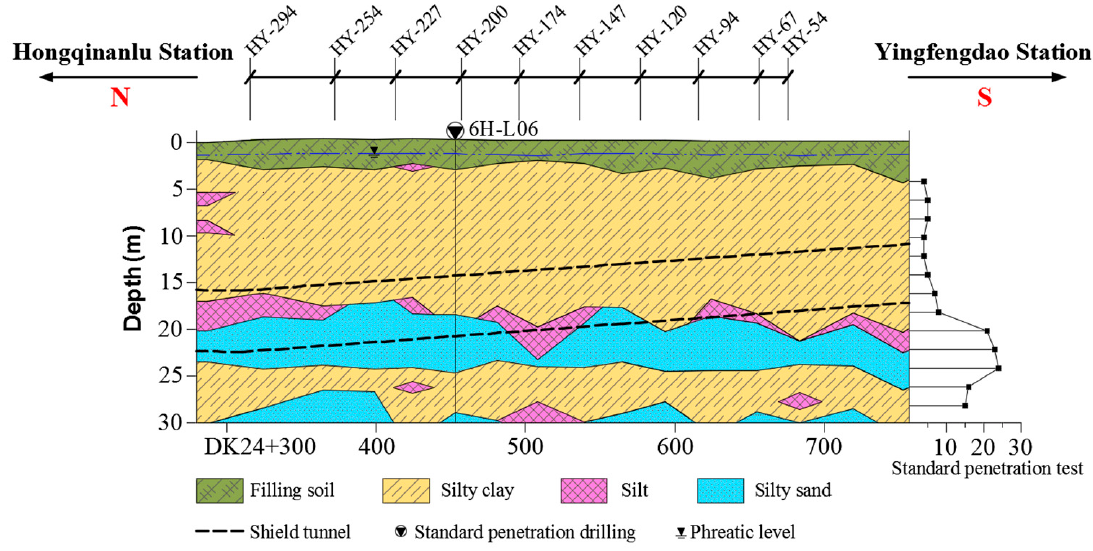
Figure 2. Geological section of the section tunnel.